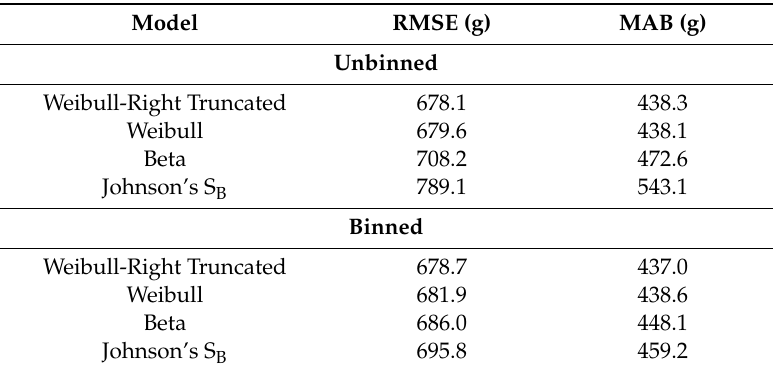
Table 5. Root mean square error (RMSE) and mean absolute bias (MAB) for each of the distributions fitted to unaggregated (unbinned) and aggregated data (20 bins) representing the vertical distribution of foliage